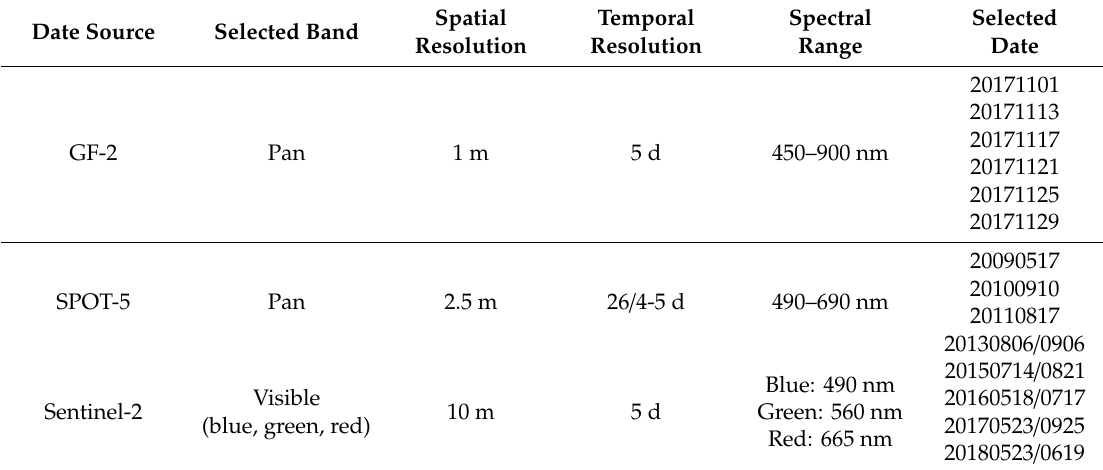
Table 2. Remote sensing data from the GF-2, SPOT-5, and Sentinel-2